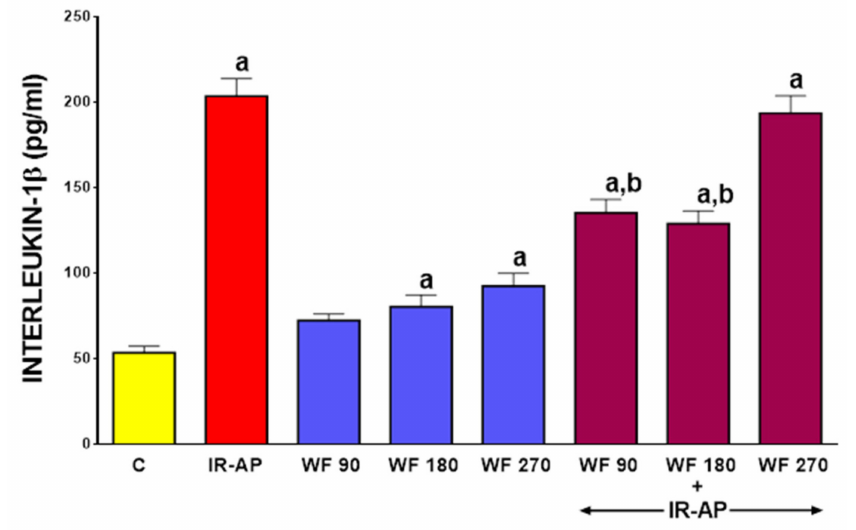
Figure 5. Impact of ischemia / reperfusion-induced acute pancreatitis (IR-AP) or / and pretreatment with warfarin given at a dose of 90, 180 or 270 µ g / kg / dose (WF 90, WF 180 or WF 270) on serum concentration of interleukin-1 β . Mean ± SEM. n = 10 animals in each experimental group. a p < 0.05 compared to control (C), b p < 0.05 compared to